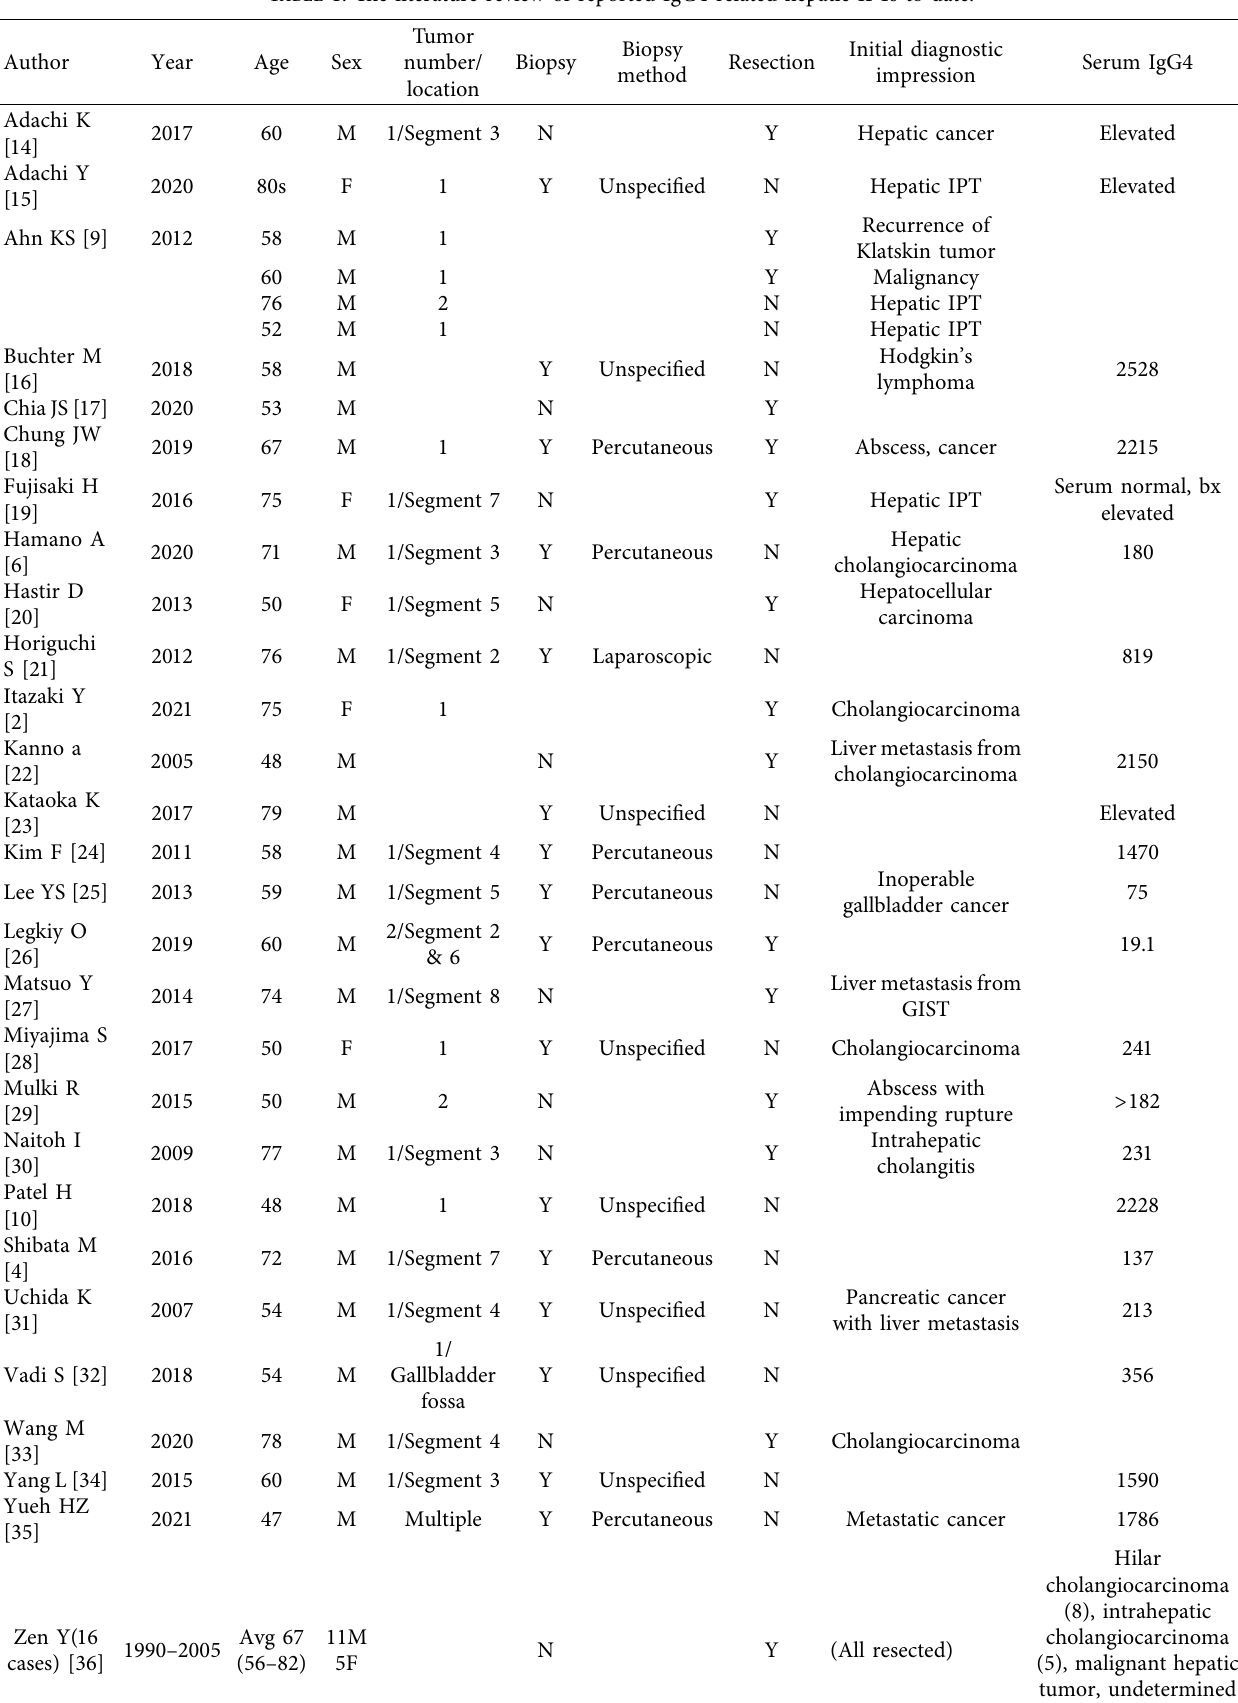
Table 1: The literature review of reported IgG4-related hepatic IPTs to